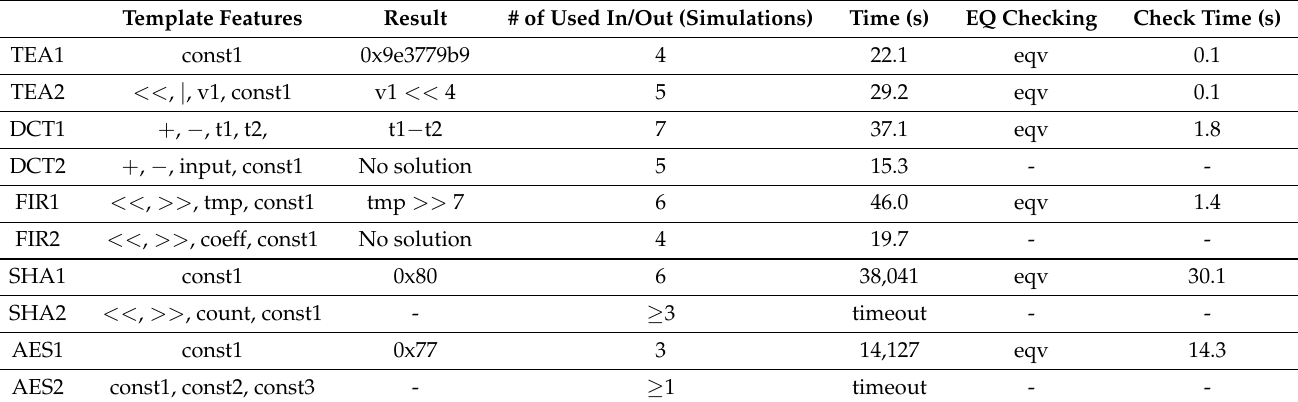
Table 5. Experimental results with larger